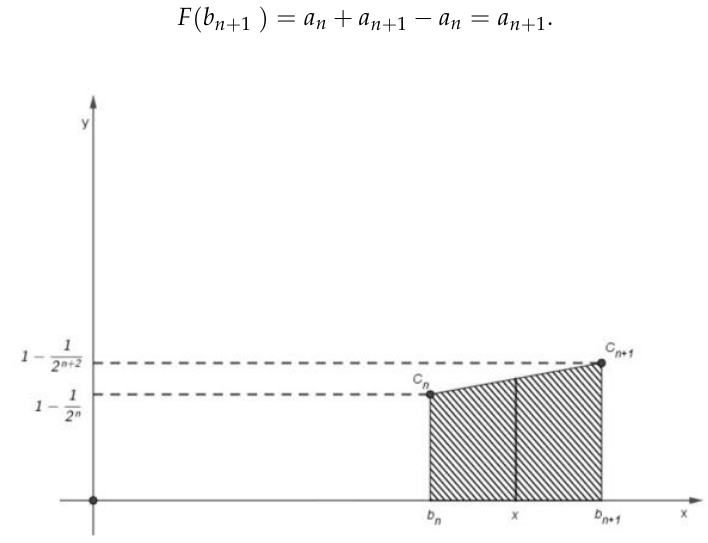
Figure 6. T he area of the trapezoid defined by points 𝐵 𝑛 , 𝐶 𝑛 , 𝑋 1 , 𝑋 2 .